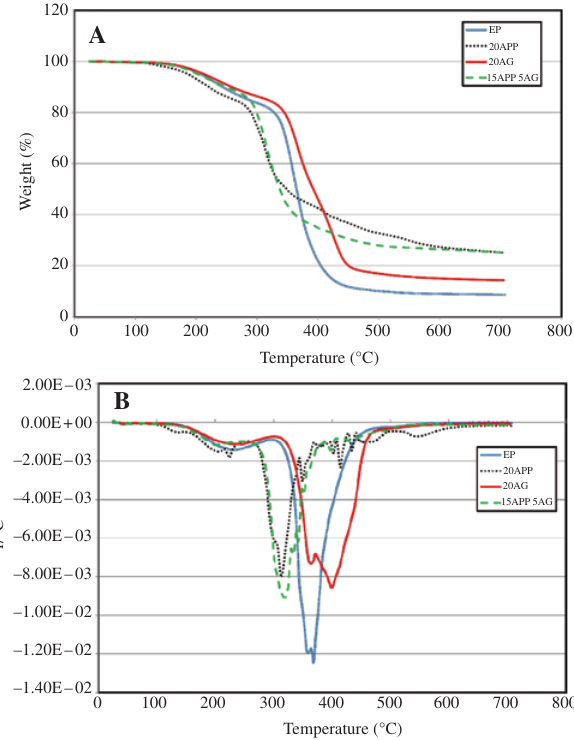
Figure 3: TG and DT curves of the neat epoxy, 20APP, 20AG